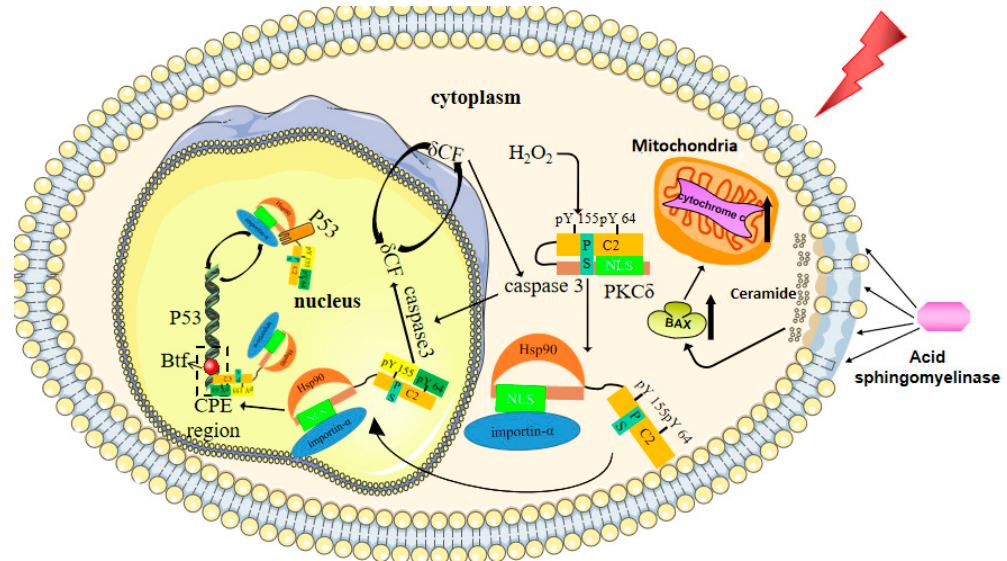
Figure 2. The mechanism of cell apoptosis in radiotherapy ‐ induced salivary gland injury . When H 2 O 2 is produced by the oxidative stress of radiation, phosphorylation at PKC δ‐ Y64 and Y155 opens the PKC δ conformation. The exposure of NLS allows both Hsp90 and importin ‐α to bind to the binding sites of PKC δ . Under the binding of importin ‐α , PKC δ accumulates in the nucleus. When phosphorylated PKC δ enters the nucleus, PKC δ can control the expression of p53 in a transcription ‐ dependent manner in the nucleus and activate p53 via the phosphorylation of different serine and threonine residues in an indirect manner. After radiation causes DNA damage, PKC δ activates Bcl ‐ 2 ‐ related transcription factor (Btf) and binds with it to the CPE region of p53, thereby inducing p53 transcription. At the same time, activated p53 can in turn promote PKC δ transcription in response to DNA damage. PKC δ entering the nucleus can also be cleaved by nuclear capsase ‐ 3 to produce pro ‐ apoptotic δ CF. Acid sphingomyelinase hydrolyzes sphingomyelin in the plasma membrane of endothelial cells to produce ceramide. Ceramide, acting as a second messenger in receptor ‐ mediated signal transduction, activates BAX. The elevation of BAX regulates vascular endothelial cell apoptosis by releasing mitochondrial cytochrome c.